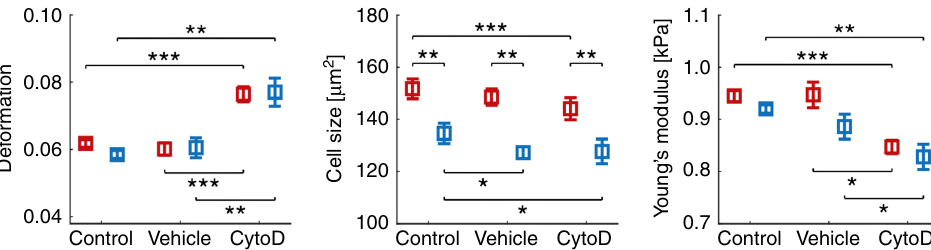
Fig. 3 Analysis of cytoskeletal alterations using virtual fl uidic channels. Statistical analysis using linear mixed models of three independent biological replicates for cell deformation (left), cell size (center) and Young ’ s modulus (right) inside a 20 µ m × 20 µ m PDMS chip (red) and 21 µ m virtual fl uidic channel inside a 30 µ m × 30 µ m PDMS chip (blue). Data compares control cells ( n = 8024; PDMS and n = 4040; virtual channel), vehicle control ( n = 8948; PDMS and n = 2778; virtual channel) as well as cells after treatment with 1 µ M CytoD ( n = 4148; PDMS and n = 1237; virtual channel). Data are presented as mean ± standard error of the mean (* p < 0.05; ** p < 0.01; and *** p < 0.001).